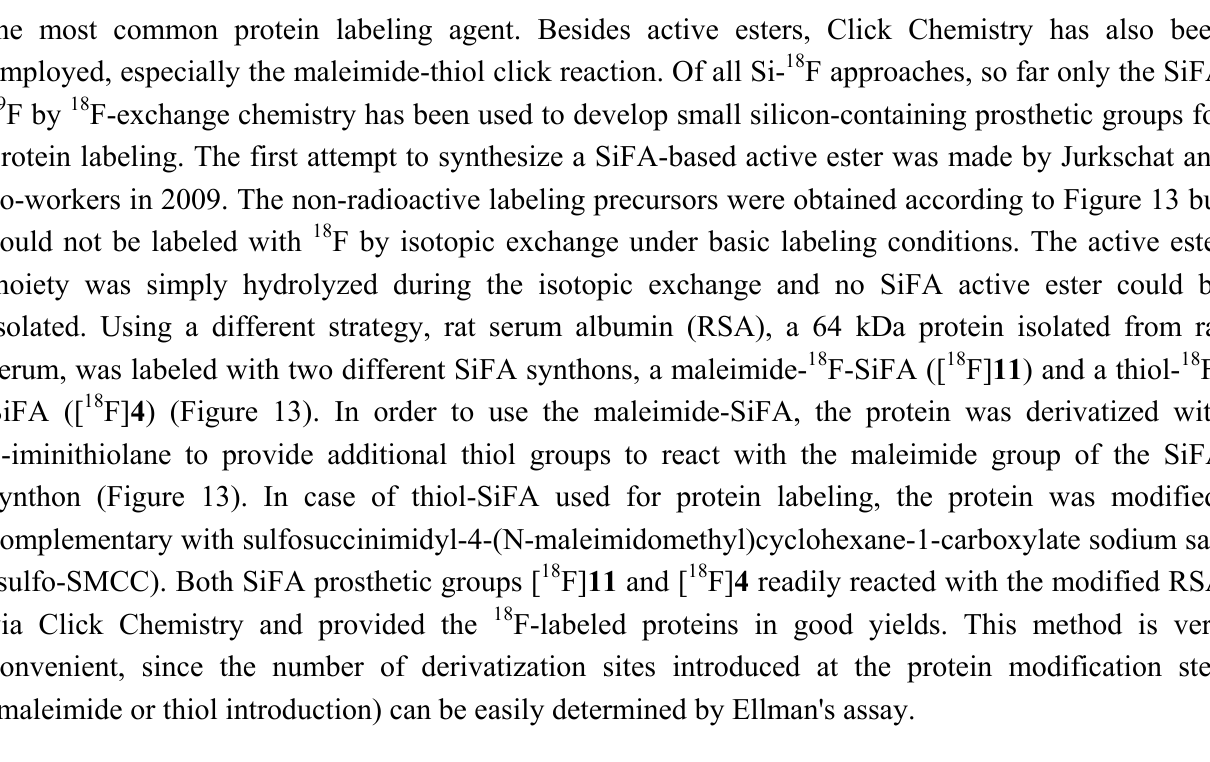
Figure 13 . Kit-like labeling of RSA using two different SiFA sythons: A) sulfo-SMCC modified RSA reacts with thiol-SiFA ( [ 18 F]4 ); B) 2-iminothiolane modified RSA reacts with maleimide-SiFA ( [ 18 F]11